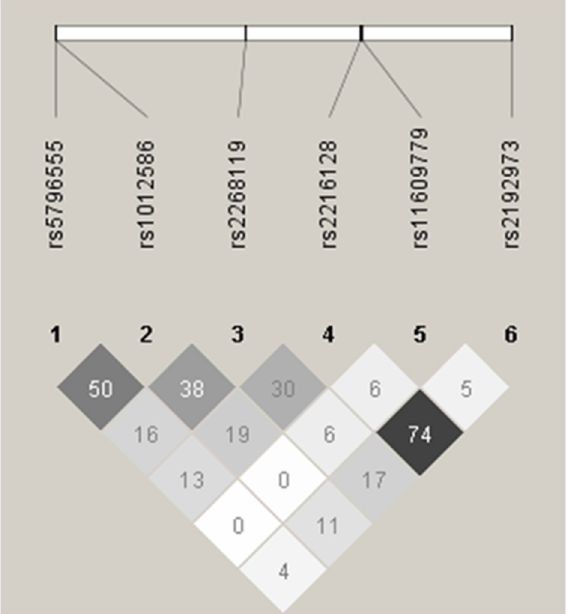
Figure 1. GRIN2B linkage disequilibrium. Haploview plot showing pairwise linkage disequilibrium (r 2 values) for 6 SNPs of GRIN2B based on the sample’s genotypes. Table 2. GRIN2B allele frequencies and Hardy-Weinberg equilibrium’s